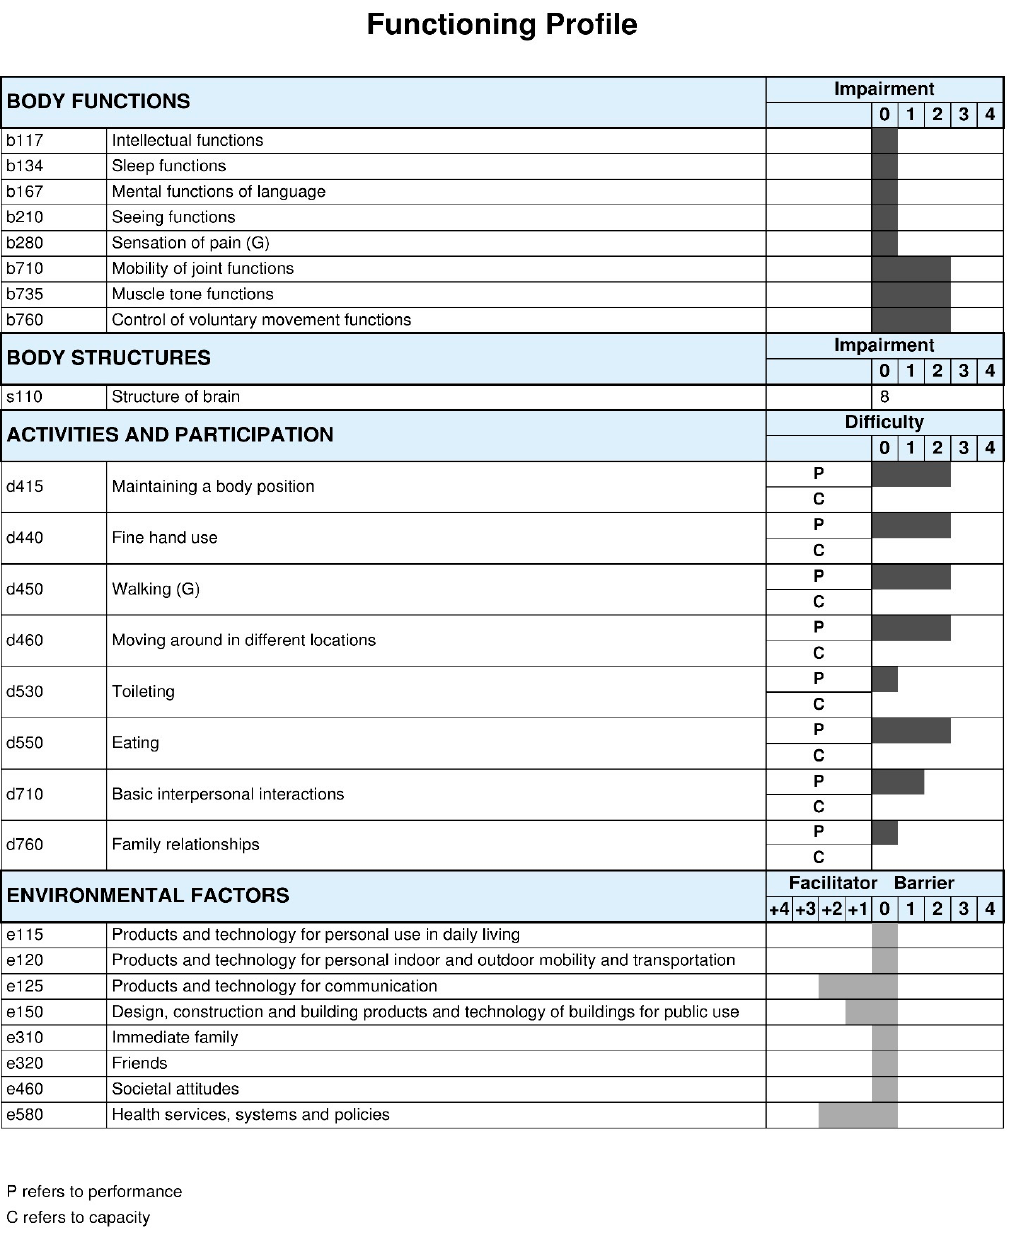
Figure 3. Functioning profile of the Russian children, GMFCS levels I to III. The ICF qualifiers use to create the profile of functioning of this study sample represent the qualifiers that have the highest percentage within each ICF category.